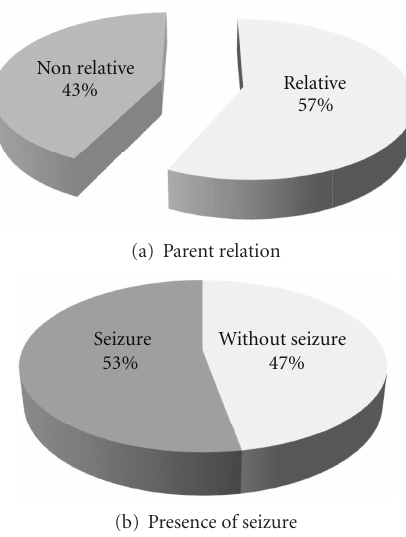
Figure 3: The classification of patients based on the relativity (a) and presence of seizure